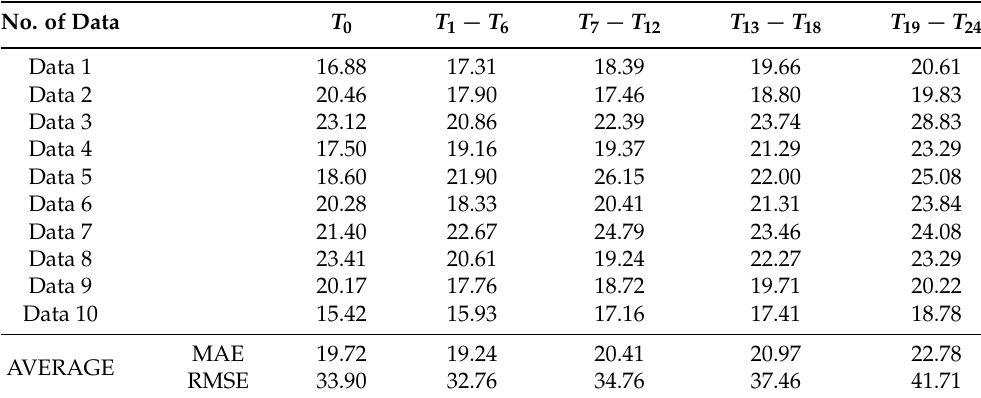
Table 5. The results of aggregating two data flow with simple summation in all 10 times. The values in the table are the MAE of AQI values.